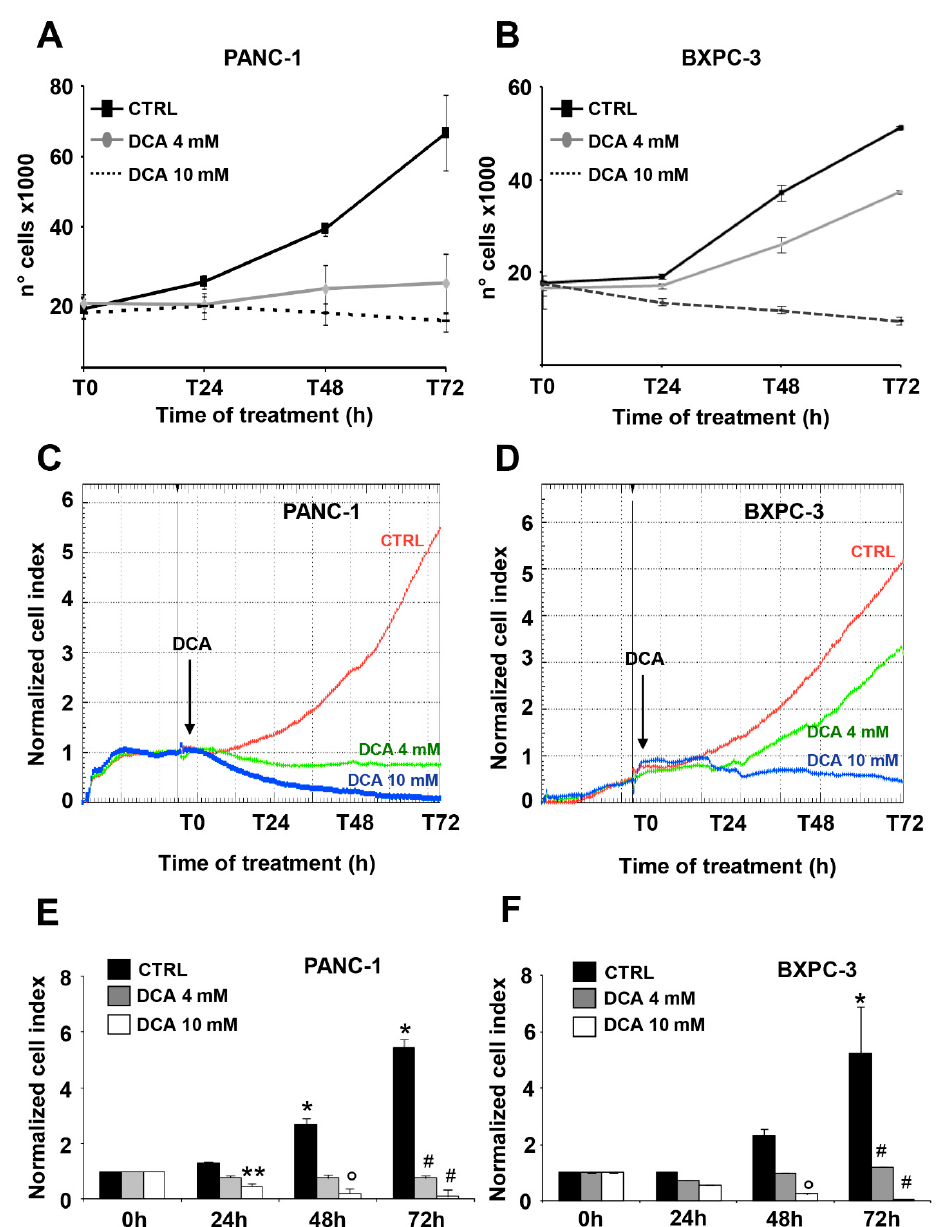
Figure 1. E ff ect of dichloroacetate (DCA) on cell growth and proliferation. Cell growth curves of cultured PANC-1 ( A ) and BXPC-3 ( B ) seeded at the same density, cultured for 72 h without CTRL (black line) or with 4 mM DCA (gray line) and 10 mM DCA (dotted line). Cells were counted every 24 h and the values shown are means ± SEM of three independent time courses. Dose- and time-dependent e ff ect of DCA treatment on PANC-1 ( C ) and BXPC-3 ( D ) proliferation assessed using xCELLigence system. A representative profile for both cell lines is shown, indicating the cell index normalized to the last cell index recorded before DCA addition, measured in real time for 72 h. Normalized cell index quantified in PANC-1 ( E ) and BXPC-3 ( F ) cells treated with DCA indicated as mean ± SD of three independent experiments, recorded at the indicated time points. Analysis was conducted using one-way Anova and Bonferroni post-test. * p < 0.001 vs. CTRL; ** p < 0.05 vs. CTRL 24h; ◦ p < 0.001 vs. CTRL 48 h; # p < 0.001 vs. CTRL 72